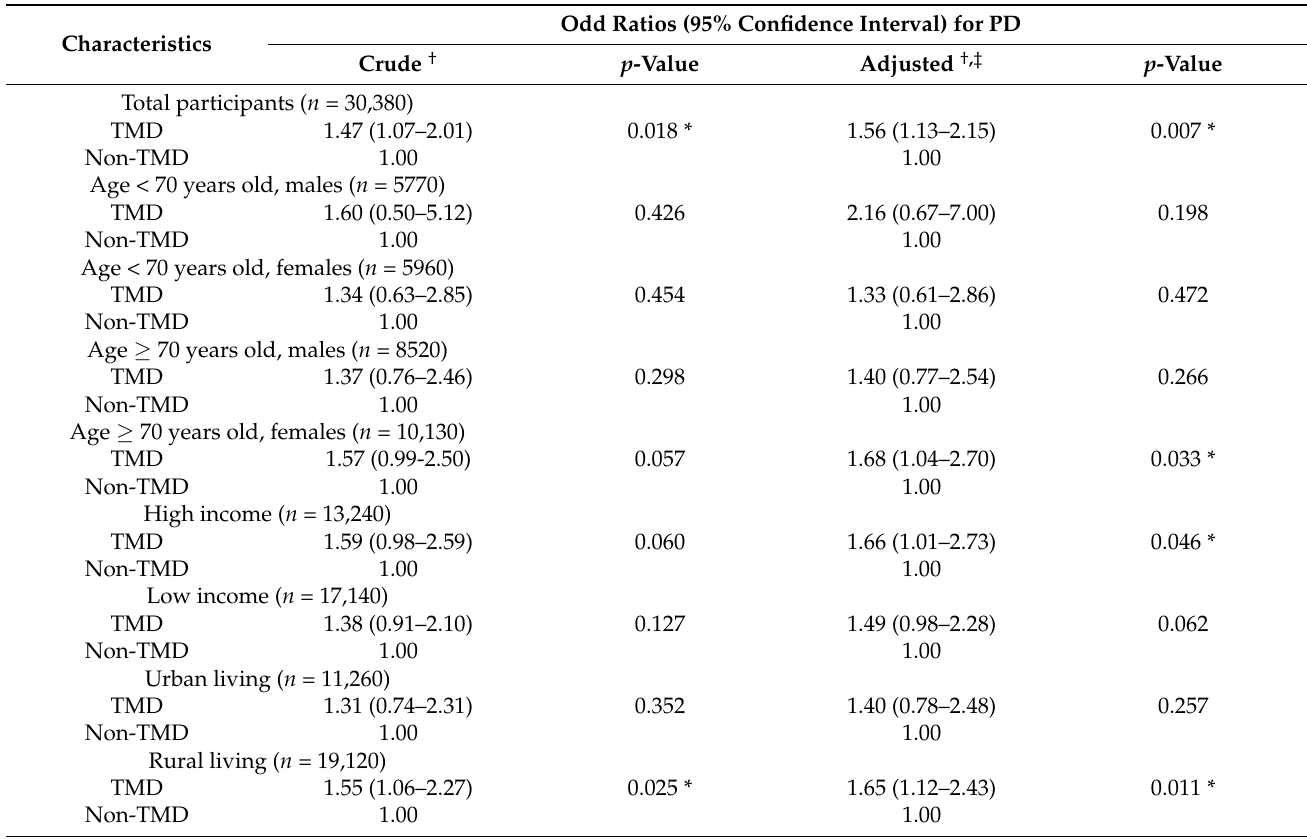
Table 3. Odd ratios for PD in TMD and non-TMD groups in Study